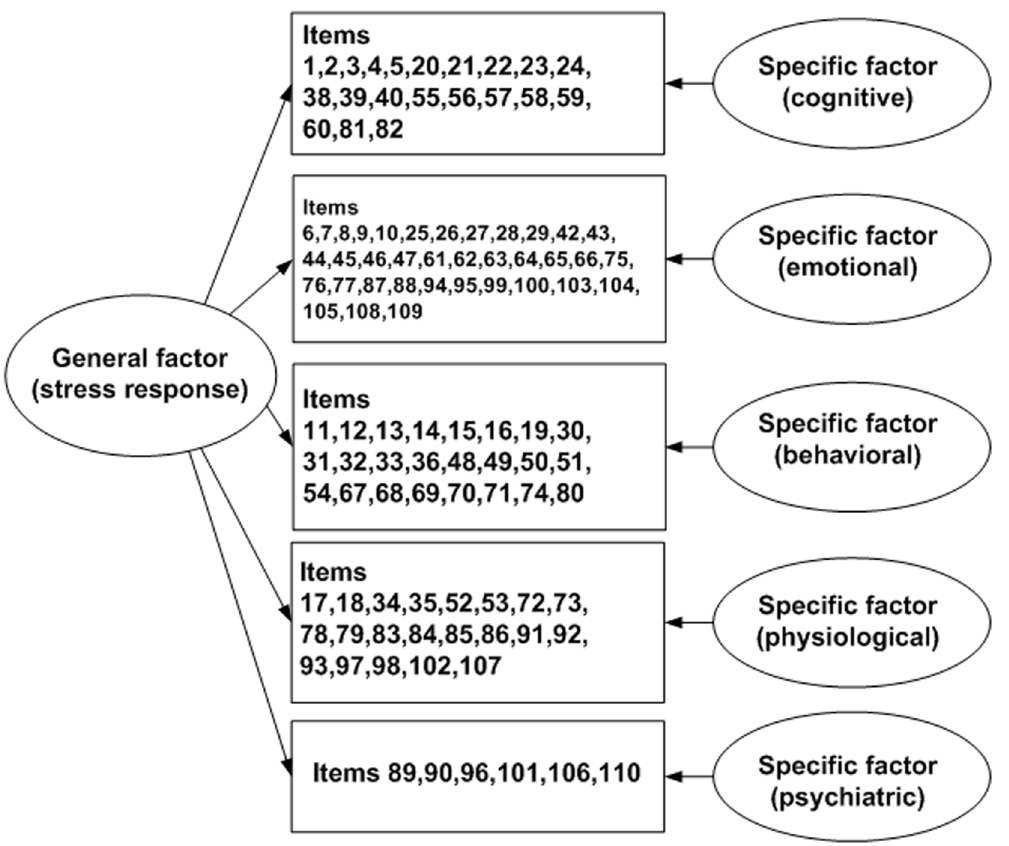
Figure 1. Bifactor structure of ASRS. Structure of the hierarchical model of the ASRS constructed using bifactor analysis. In the original scale, 110 items load on five subscales respectively. In the bifactor analysis, all the items have loadings on both the general factor and one of the subscale specific factors.